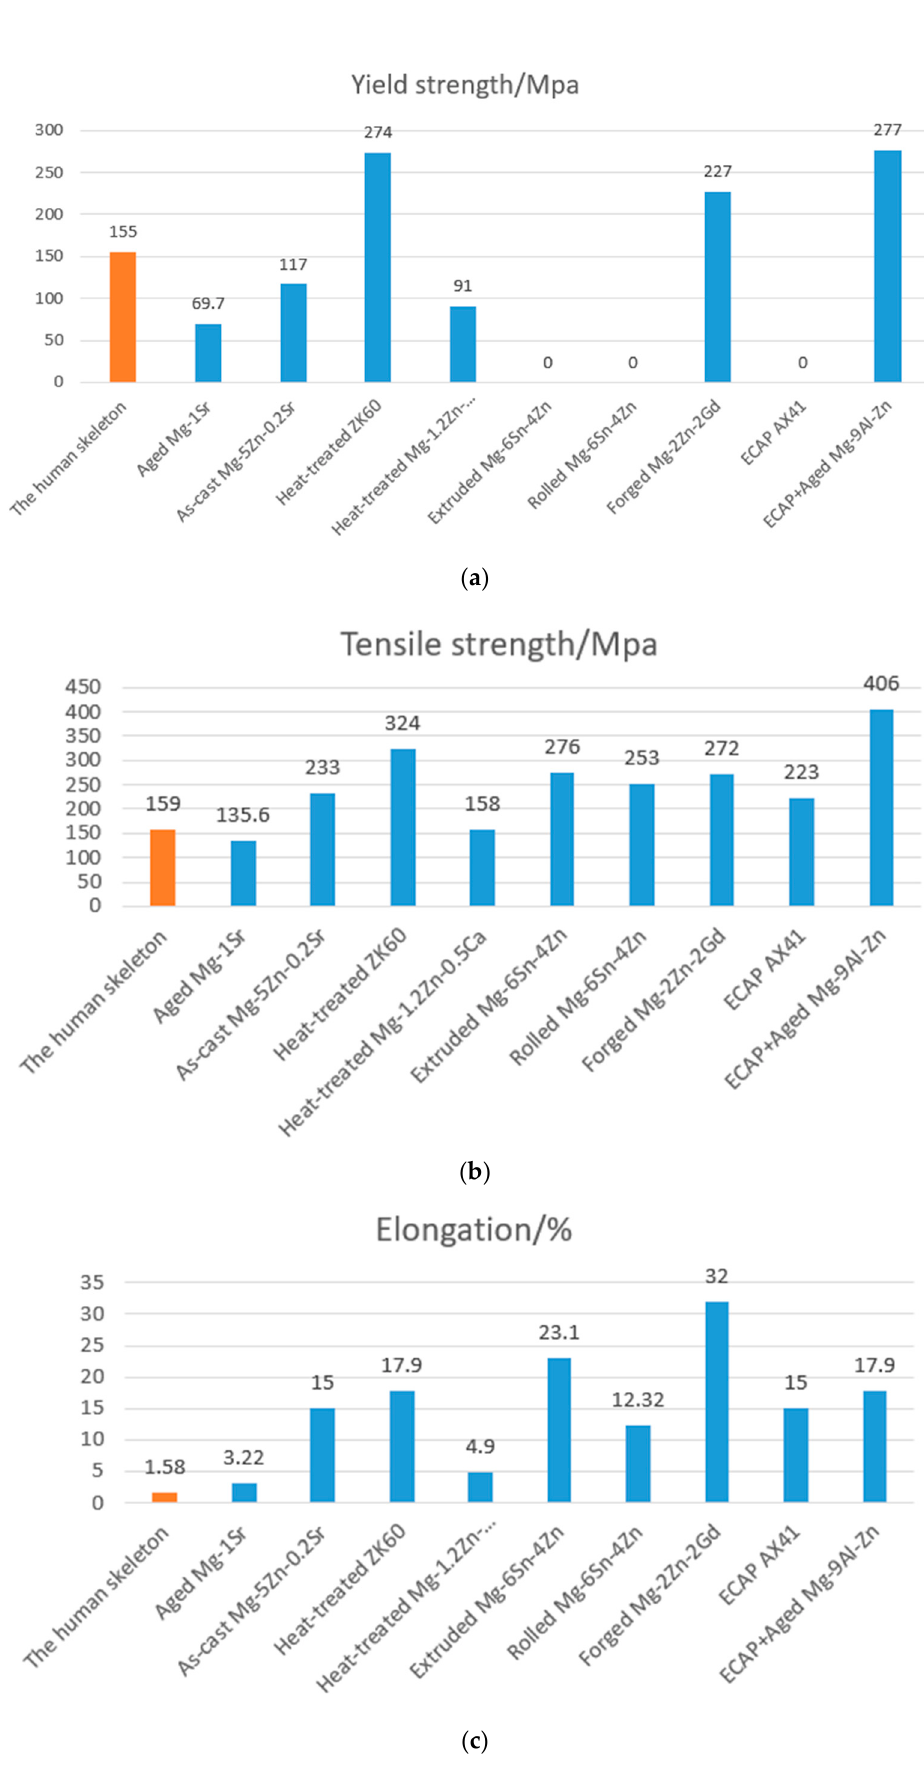
Figure 10. ( a ) Comparison of the yield strength of individual magnesium alloys (the mean of 0 is